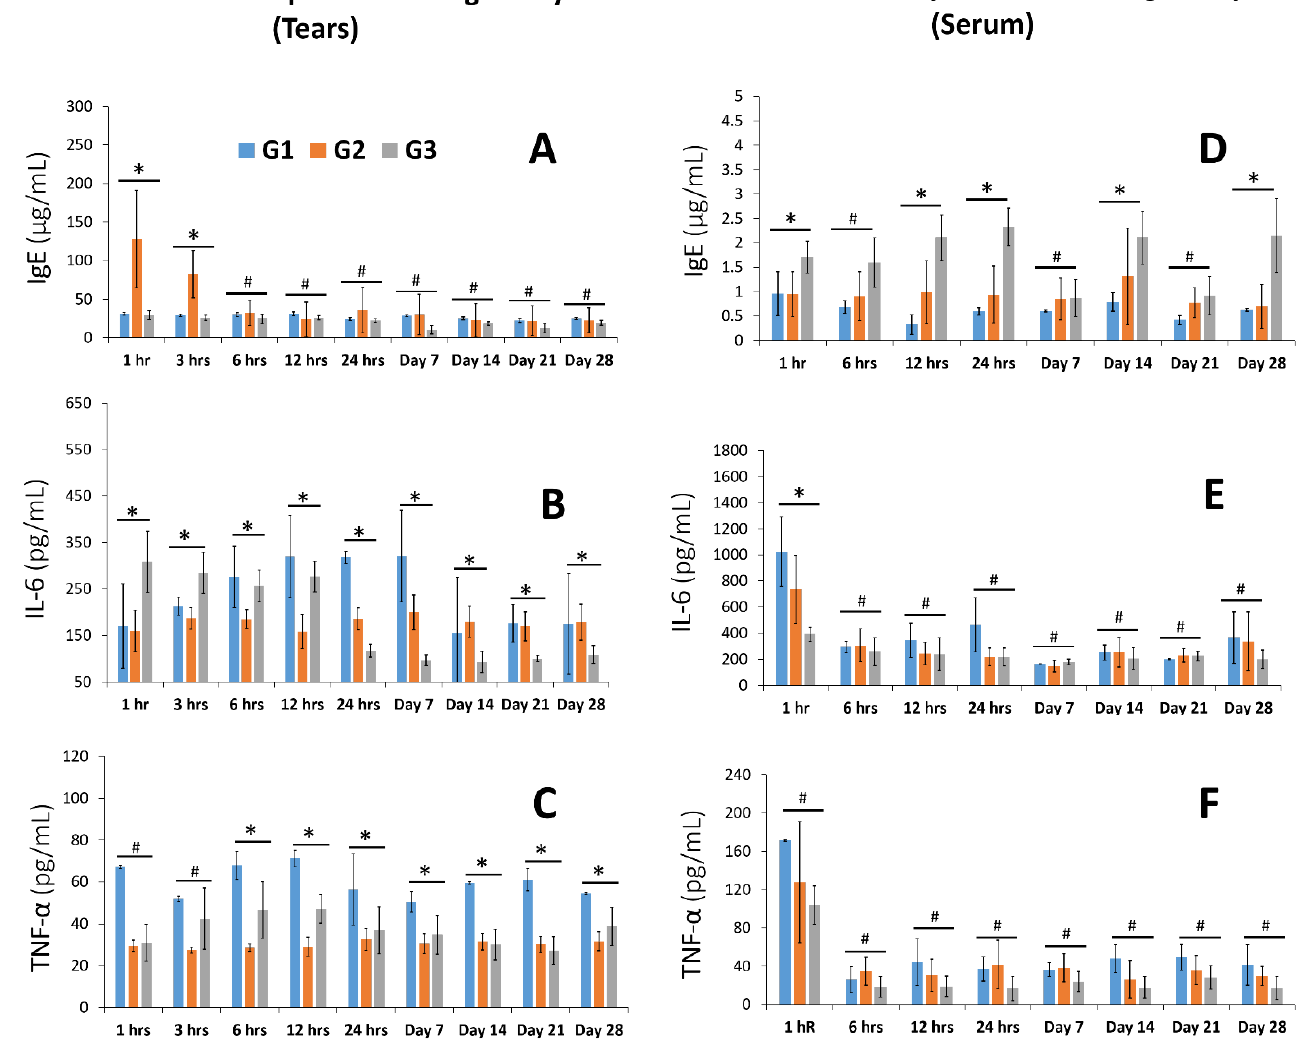
Figure 7. Serum and tear levels of IgE, IL-6, and TNF- α after treatment with En+/En − hLMSCs in rabbits. ( A – C ) Bar charts displaying the ELISA-determined concentrations of the cytokines IgE, IL-6, and TNF- α in rabbit serum. ( D – F ) Quantitative analysis of rabbit tear samples for the cytokines interleukin (IL)-6, tumor necrosis factor α , and interleukin (IL)-1 presented as bar graphs. Both the experimental and control groups showed a downward trend in cytokine levels, suggesting that there was no localized toxicity in the eyes of the recipients. * p ≤ 0.05; # p > 0.05. G1—Sham treated group; G2 — Treated with En − hLMSCs; G3 — Treated with En + hLMSCs.